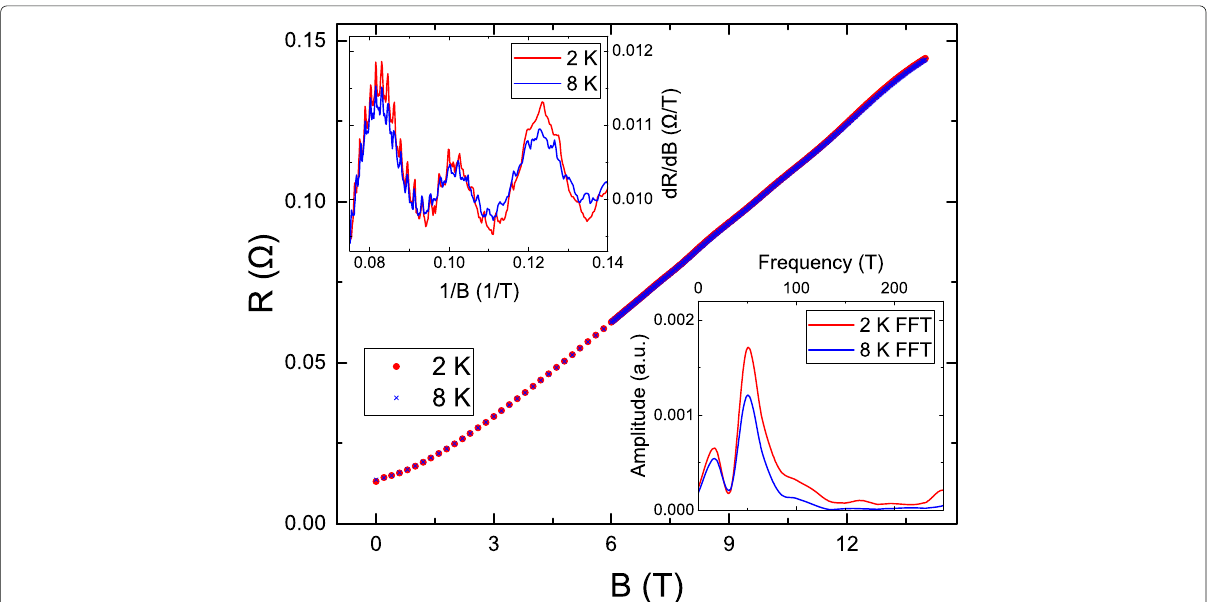
Fig. 1 The magnetoresistance as a function of magnetic fields at 2 and 8 K. The top-left inset shows the dR / dB as a function of inverse magnetic fields. It reveal a periodic oscillations. The bottom-right inset shows the fast Fourier transform of the SdH oscillation and a sharp peak at 48 T for both 2 and 8